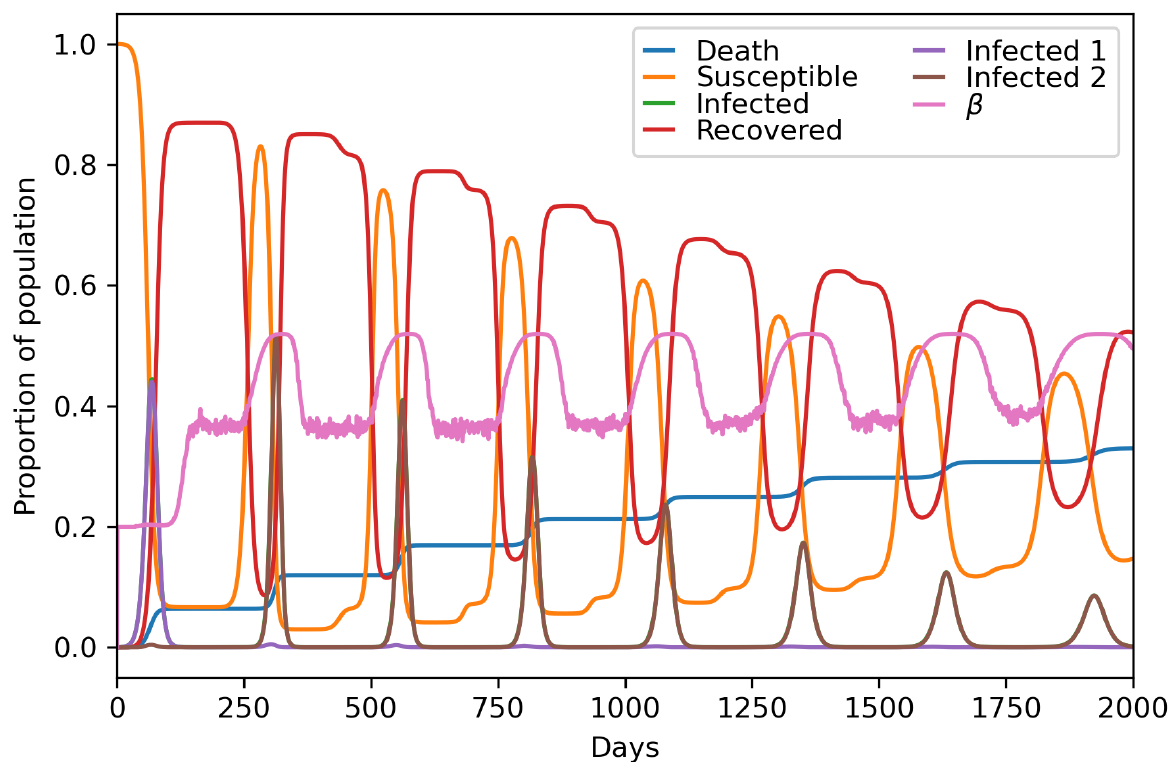
Figure 2. SIR adjusted dynamic of COVID-19 evolution along 2,000 days, adjusted for the Manaus population, migration rates, and original (Infected 1, blue line) and Gamma P1 (Infected 2, orange line) variants. β (green line) = combined β-infection rate for both variants (Σβi/Σ infected). Oscilation are due to the variation of number of infected